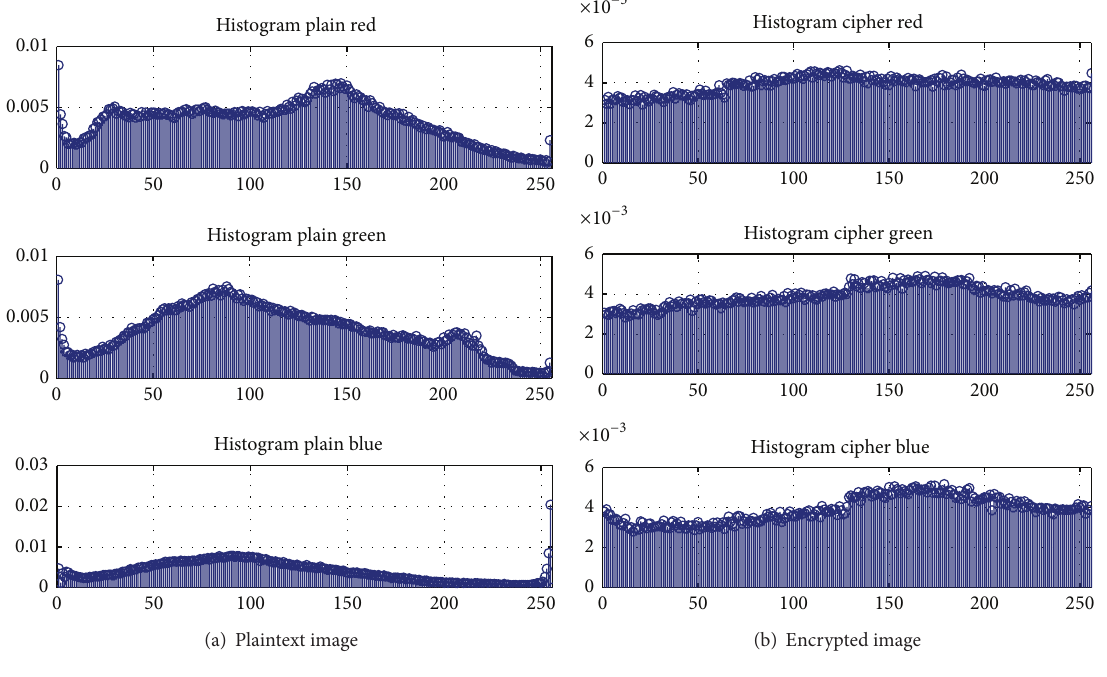
Figure 9: Histogram analysis